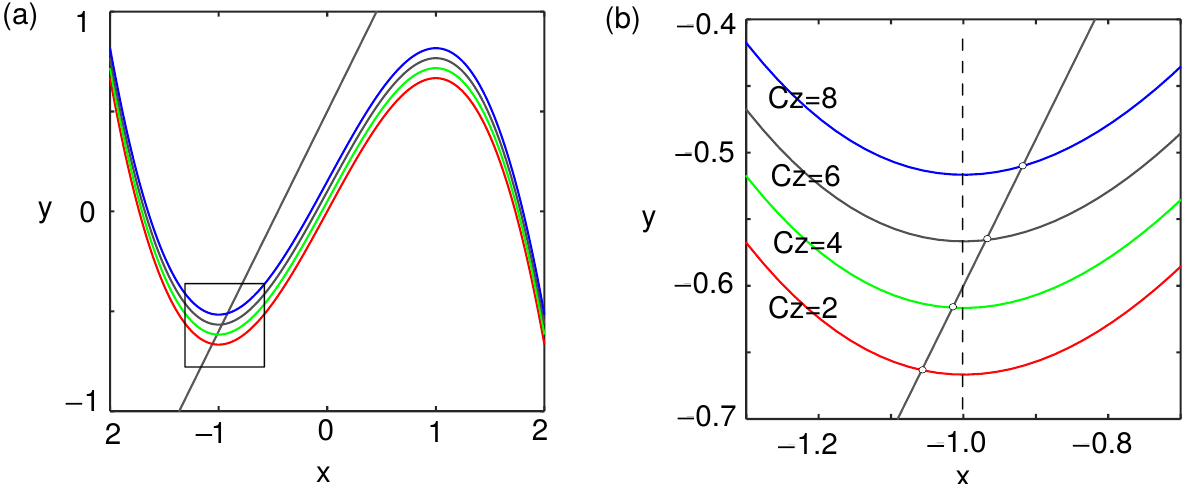
Figure 2. Nullcline plots for the Equations (1) and (2) at different Cz values. ( a ) Whole-range plot shows the interlocation of cubic and linear nullclines; ( b ) zoomed part of ( a ) displays changes at intersection point, see